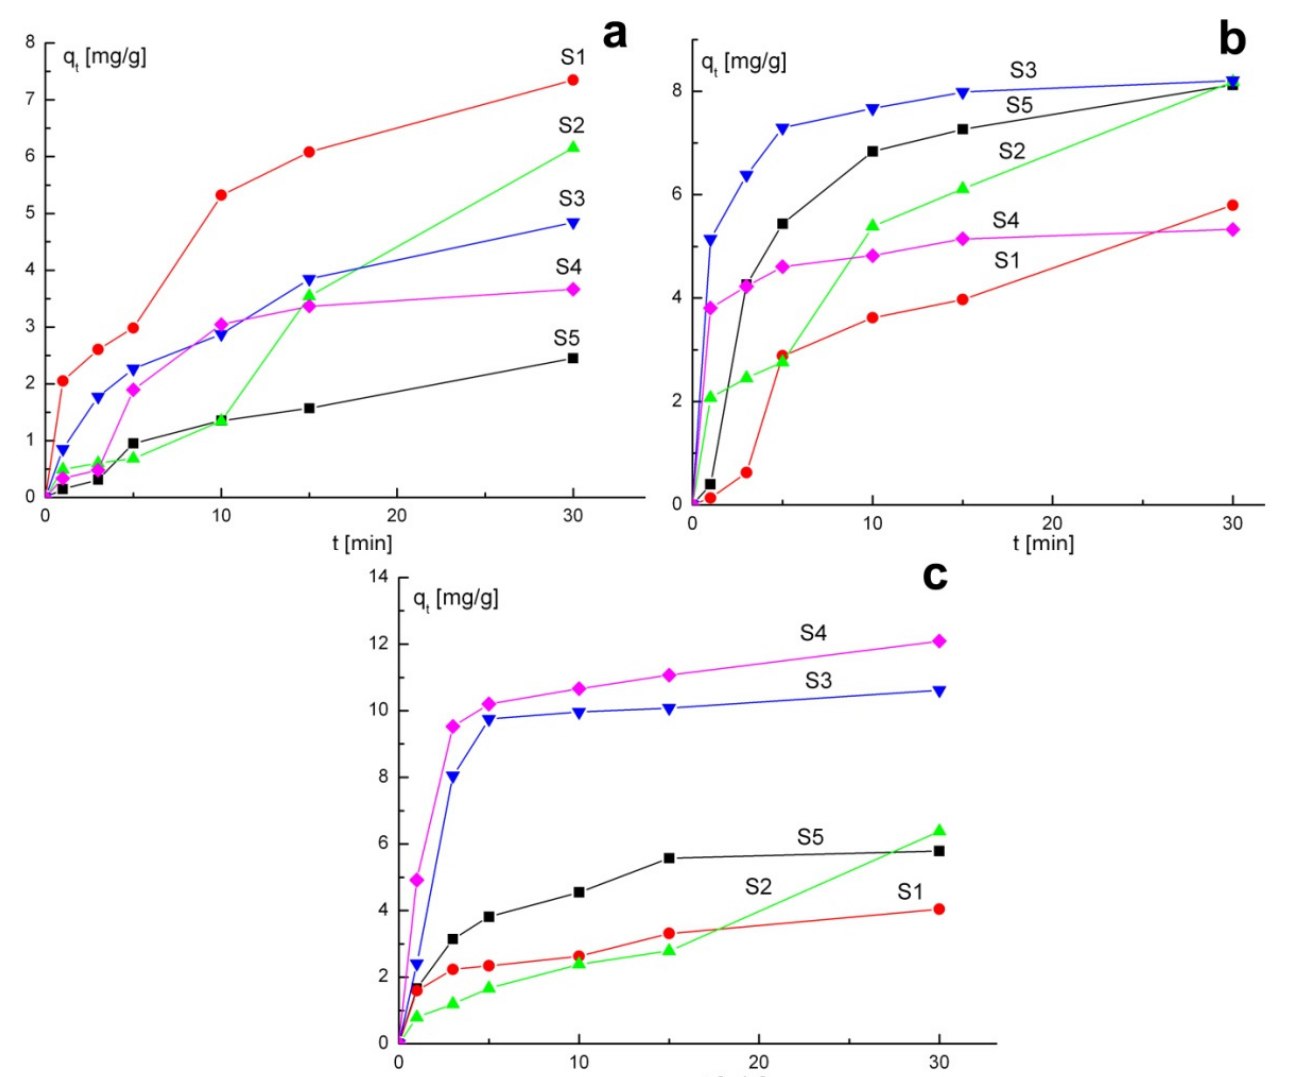
Figure 7. Kinetic curves of RhB ( a ), RR6C ( b ), and MB ( c ) absorption on synthesized samples at room temperature.